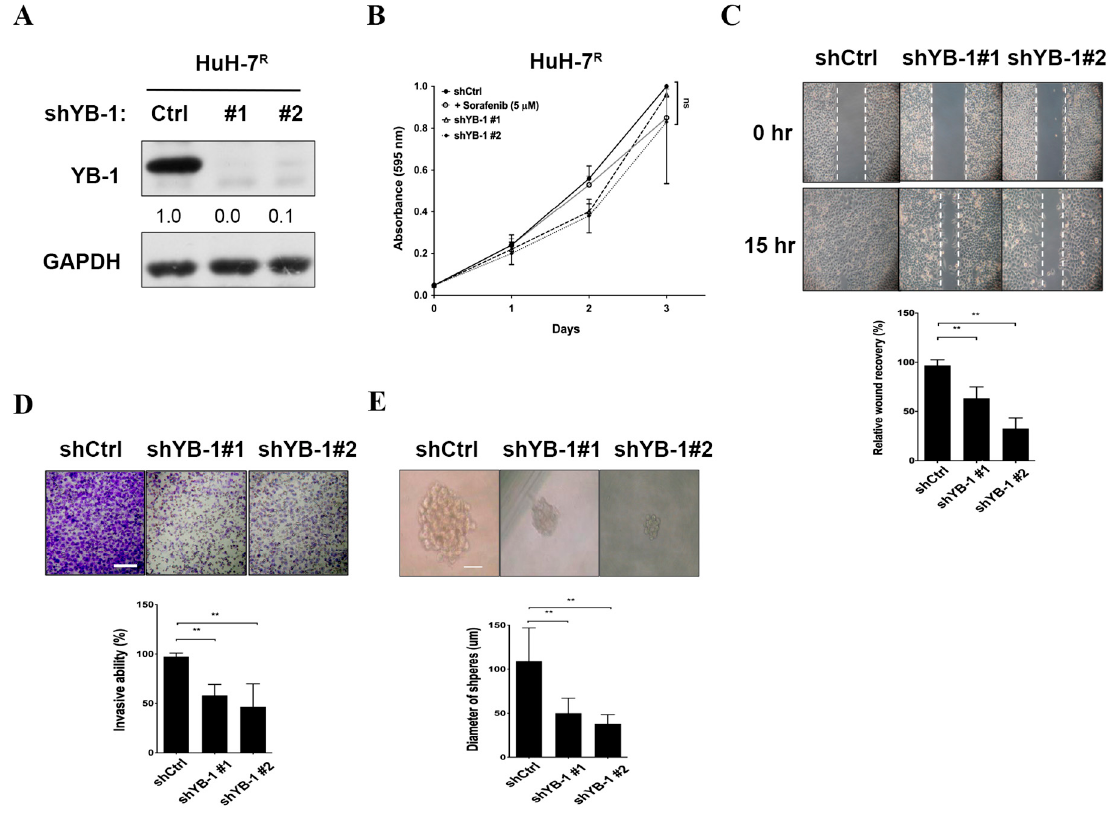
Figure 4. Knockdown of YB-1 does not inhibit proliferation, but suppresses migration, invasion, and sphere formation of HuH-7 R cells. ( A ) HuH-7 R cells were infected with lentiviruses containing shYB-1 (#1, #2) or shCtrl, and after 48 h, lysed and analyzed for YB-1 expression status by immunoblotting with the indicated antibodies. ( B ) Viability of HuH-7 R cells treated with shCtrl, shYB-1 or 5 μ M sorafenib determined at the indicated time-points with the MTT ssay. Plots depict cumulative cell absorbance versus days in culture. ( C ) Wound healing assay of YB-1 knockdown HuH-7 R cells. The micrographs depict cells migrating into the gap 0 h and 15 h after removal of the insert. ( D ) Transwell invasion assay of YB-1 knockdown HuH-7 R cells. Cells in the central field of each insert were visualized using light microscopy and quantified. ( E ) Sphere formation assay of YB-1 knockdown HuH-7 R cells. Images of the spheres formed were captured on day 9 and sphere diameters measured. Data were quantified and presented as means ± SD. All results are the representatives of at least three independent biological replicates. Scale bars = 50 μ m. p Values were determined using the t test (ns, not significant; ** p < 0.01); shCtrl, control shRNA; shYB-1, shRNA against YB-1.